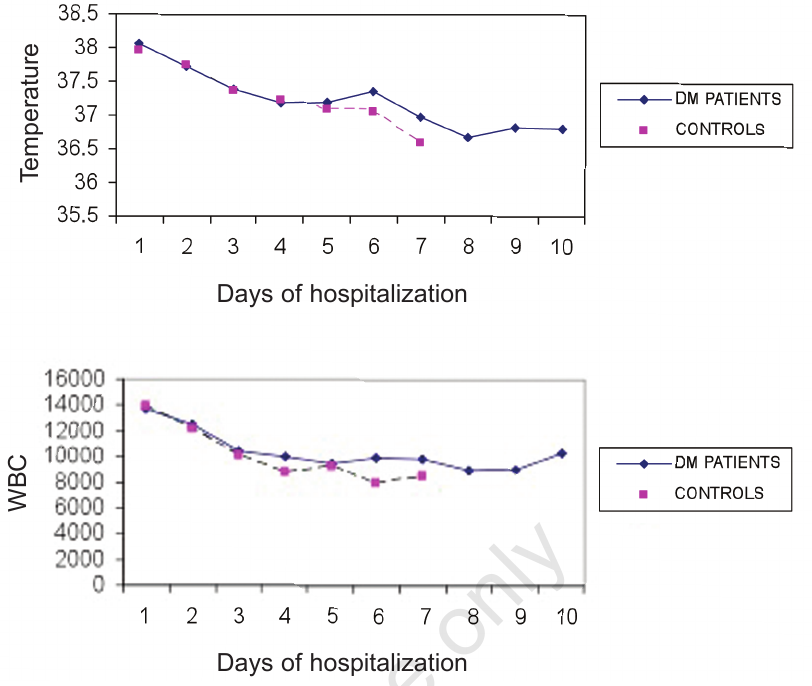
Figure 1. Average temperature (°C) and WBC (mm 3 ) in diabetics and non-diabetics with urinary tract infection.